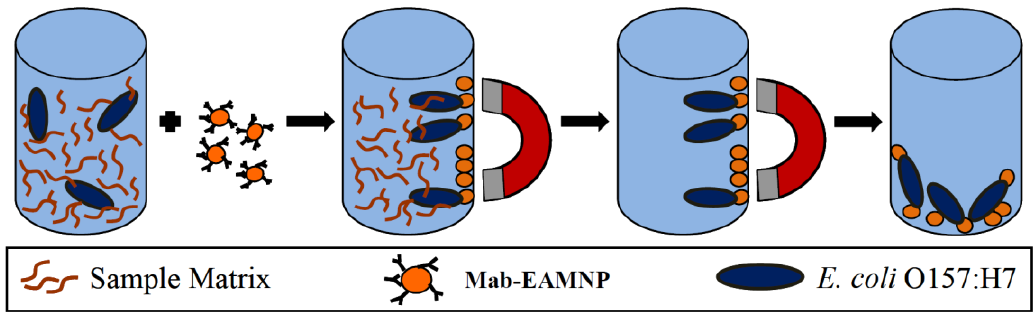
Figure 1. Immuno-magnetic separation procedure (IMS): sample plus Mab-EAMNPs → magnetic separation of target cells → removal of sample matrix → purified E. coli O157:H7- Mab-EAMNP